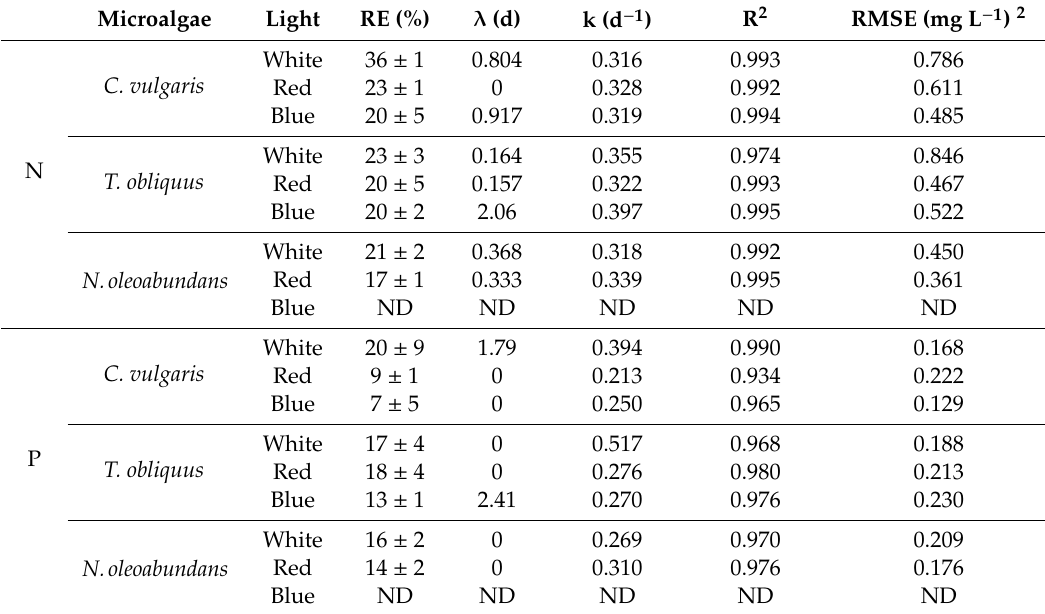
Table 4. Nitrogen and phosphorus removal e ffi ciencies and kinetic parameters of nitrogen and phosphorus uptake (obtained through the modified Gompertz model) determined for the studied microalgae grown under di ff erent light